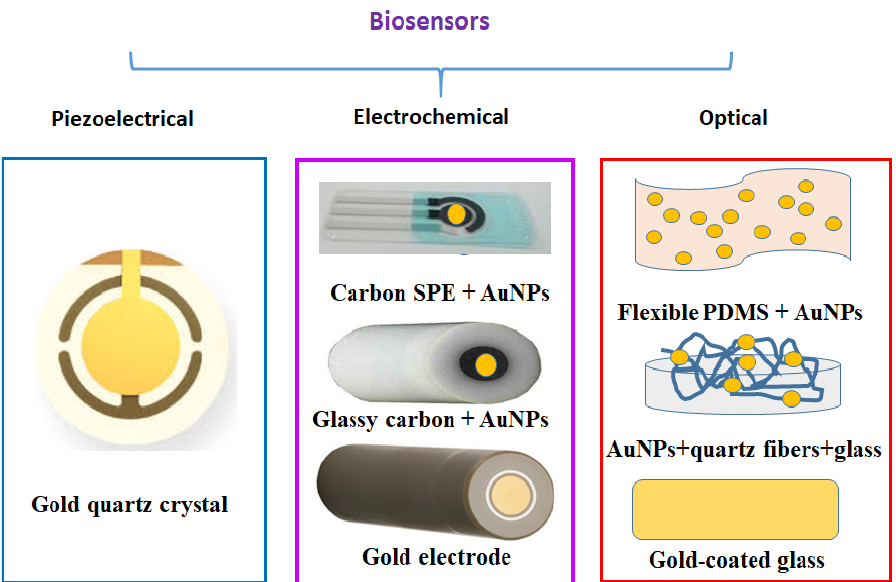
Figure 1. Solid and flexible electrodes used for functionalization with biological molecules and their use for piezoelectrical, electrochemical, and optical biomarker investigations. SPE—screen-printed electrodes; PDMS—poly-dimethylsiloxane .